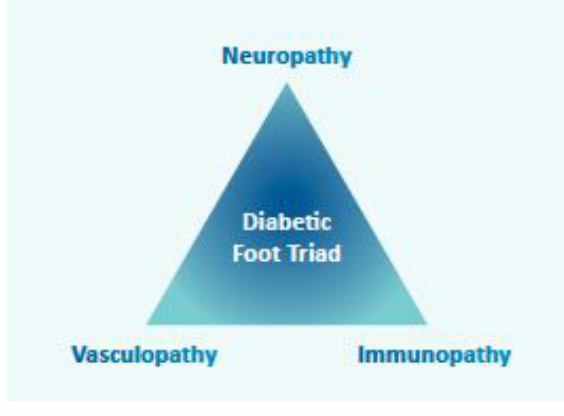
Figure 1. Diabetic Foot